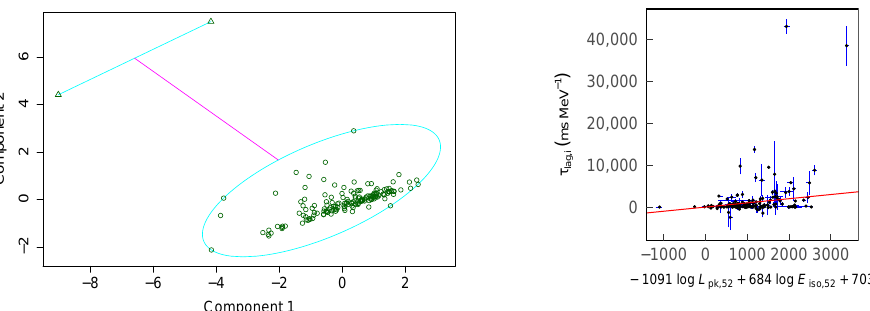
Figure 3. Similar to Figure 1, with the three parameters being τ lag,i , L pk,52 and E iso,52 . The outliers are GRBs 980425B and 030528A. The linear regression result is τ lag,i = ( − 1091 + 150 −